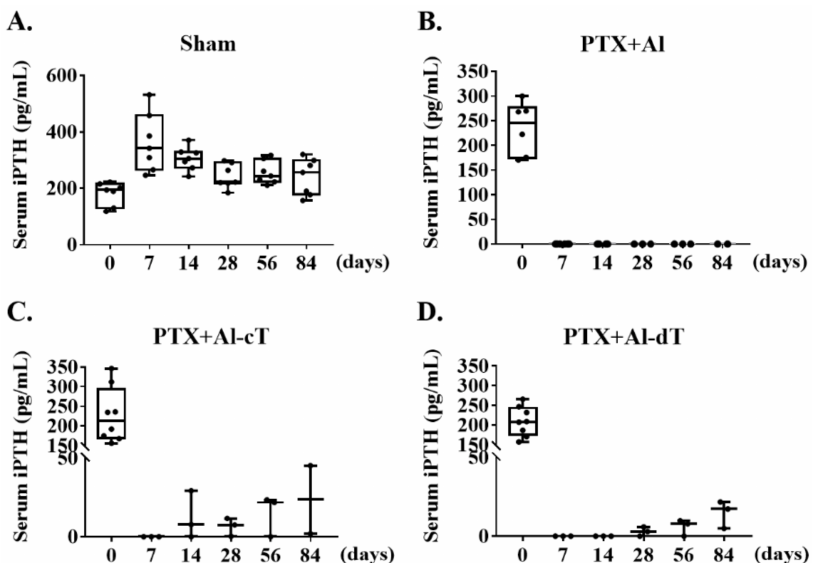
Figure 6. Assessment of the serum iPTH levels in each experimental animal group. ( A ) The sham group showed a normal range of iPTH during the experiment. Except for the sham group, iPTH levels in all experimental groups decreased after PTX. ( B ) Reduced iPTH was detected in PTX+Al until the end of the experiment. ( C ) PTX+Al-cT and ( D ) PTX+Al-dT showed iPTH levels, but PTX+Al-dT only statically restored iPTH.